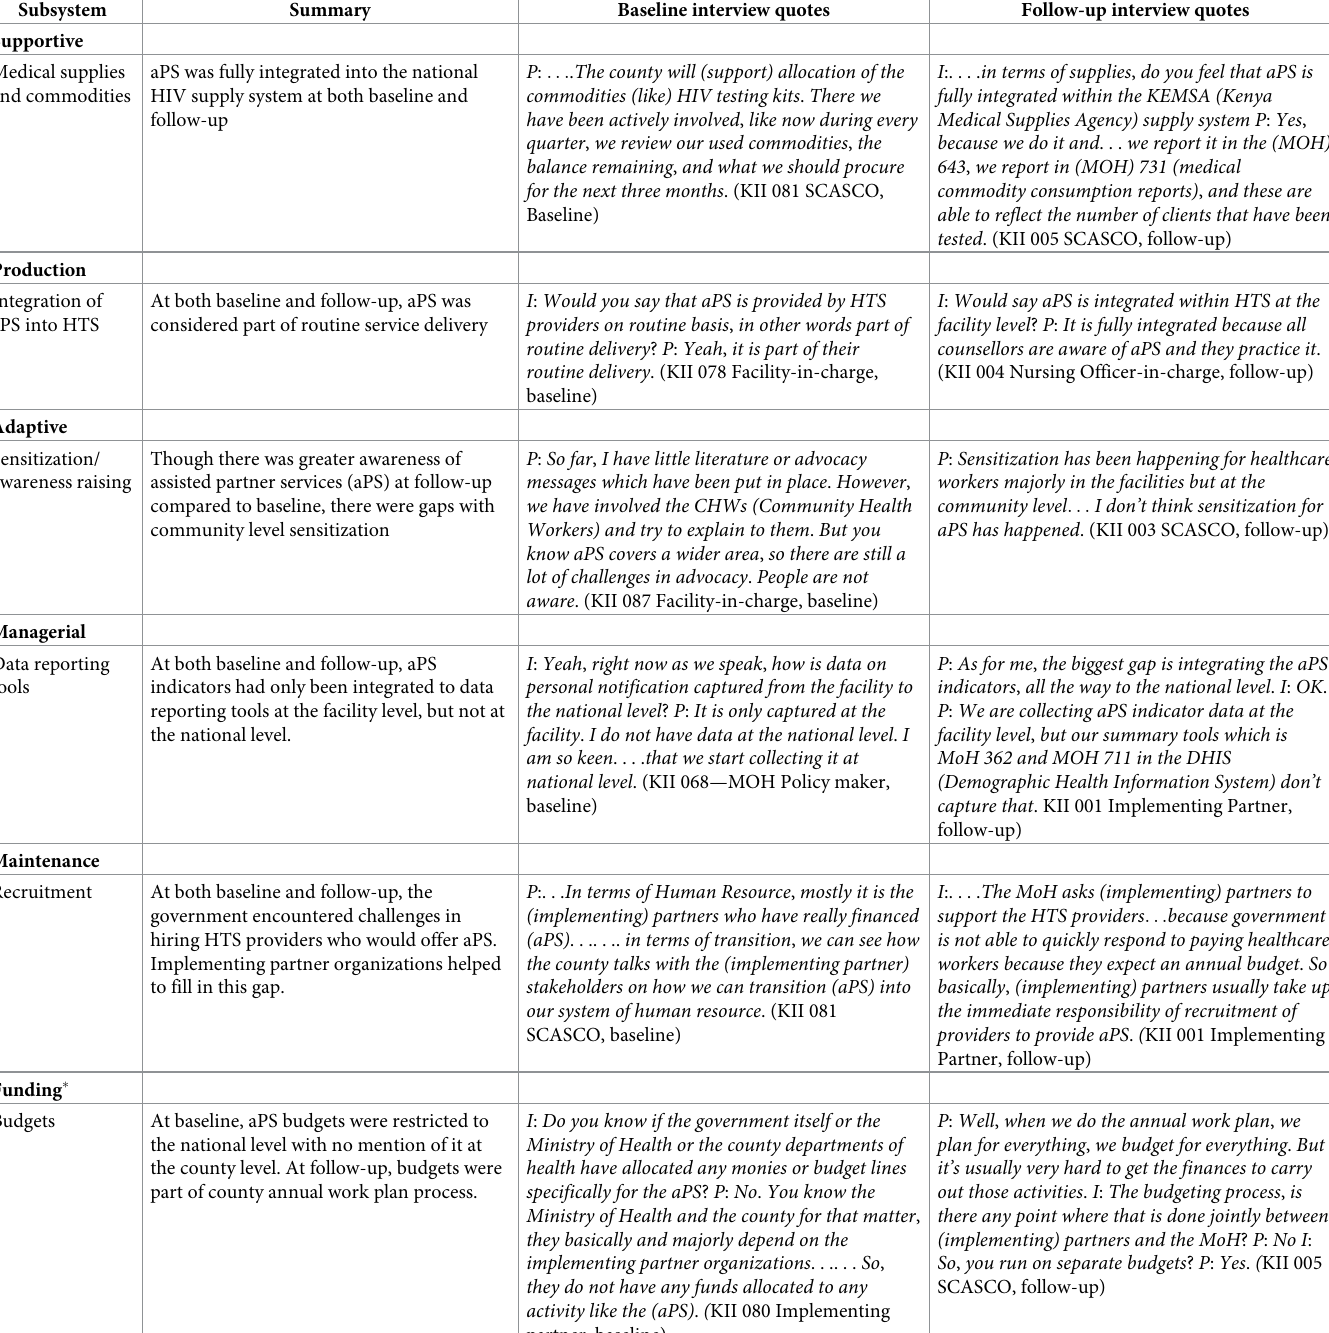
Table 2. Quotes comparing integration at baseline and